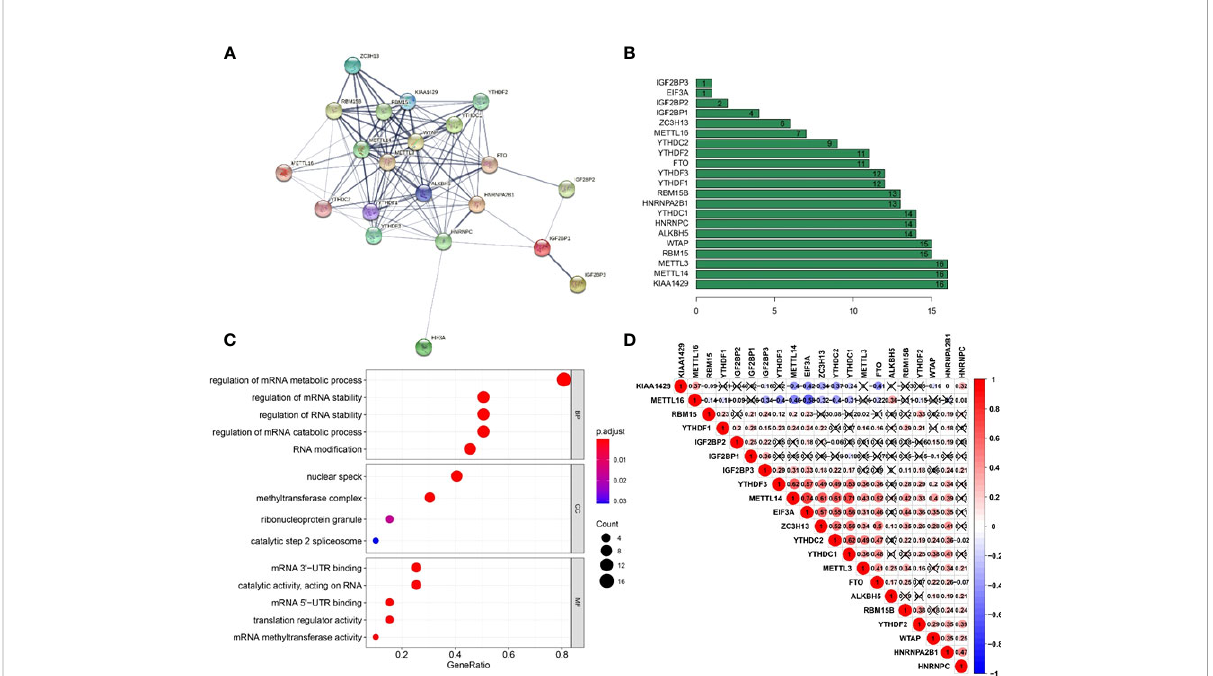
FIGURE 3 Interaction and correlation between m6A RNA methylation regulators in cervical cancer. (A) A PPI network was constructed to evaluate the interaction between m6A RNA methylation regulators. (B) Histogram of key M6A regulators. (C) Functional annotation of 21 m6A methylation regulators. (D) The correlations among m6A RNA methylation regulators were analyzed by Pearson